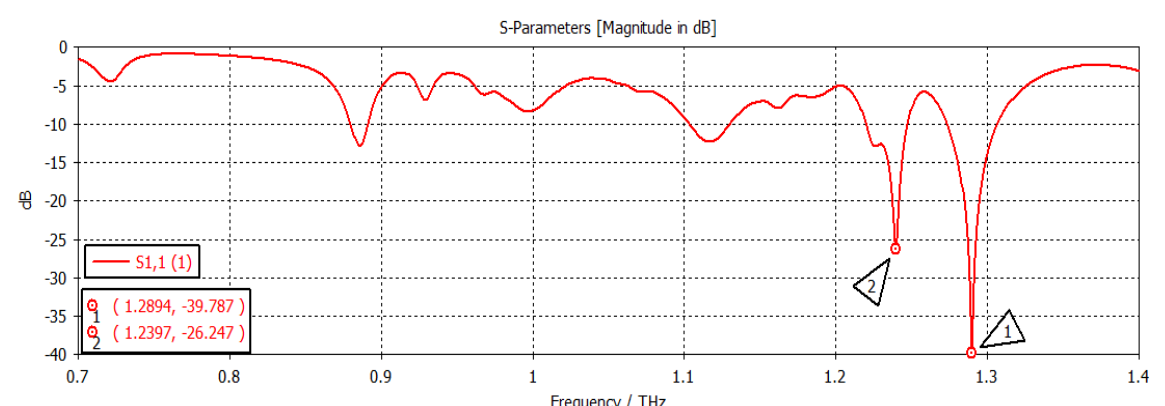
Figure 9. Chemical potential = 0.6. Table 2. Graphene parameters. Parameter